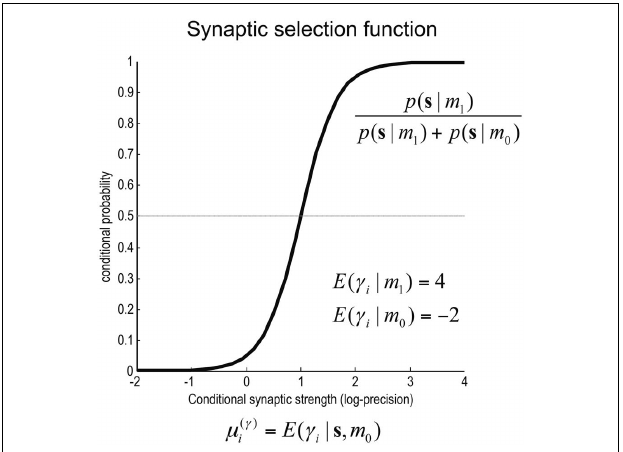
FIGURE 4 | Synaptic selection function. This sigmoidal function measures the relative probability of two models with and without a